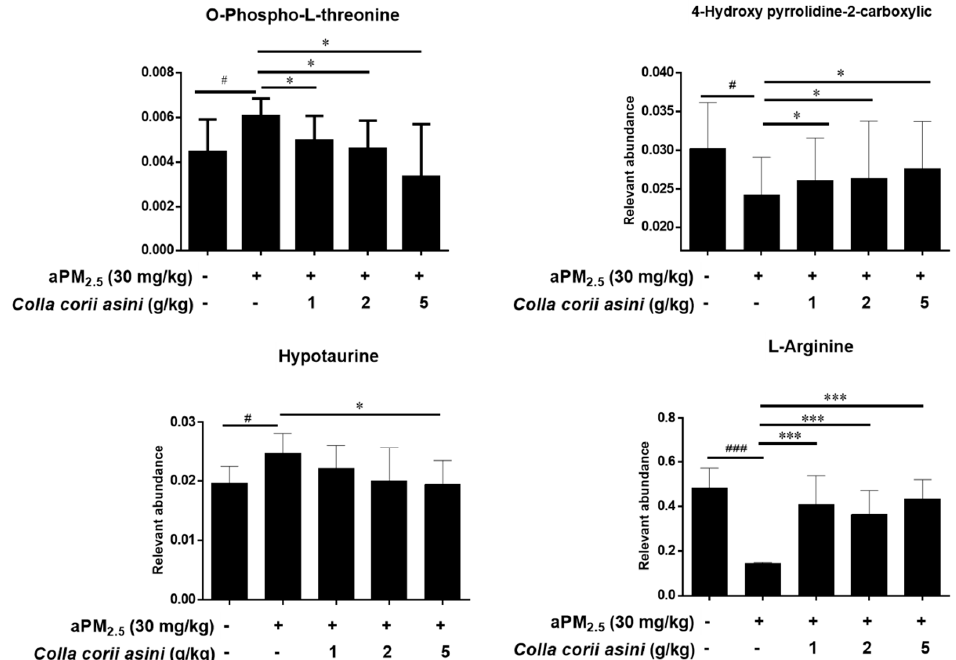
Figure 6. Protective effects of Colla corii asini against aPM 2.5 -induced alteration of amino metabolic profile. Data were calculated from the ratio of the mean peak areas in the aPM 2.5 and Colla corii asini groups and normalized to L-norvaline (internal standard); # p < 0.05 and ### p < 0.001, versus the control group; * p < 0.05 and *** p < 0.001, versus the aPM 2.5 group, n = 8.